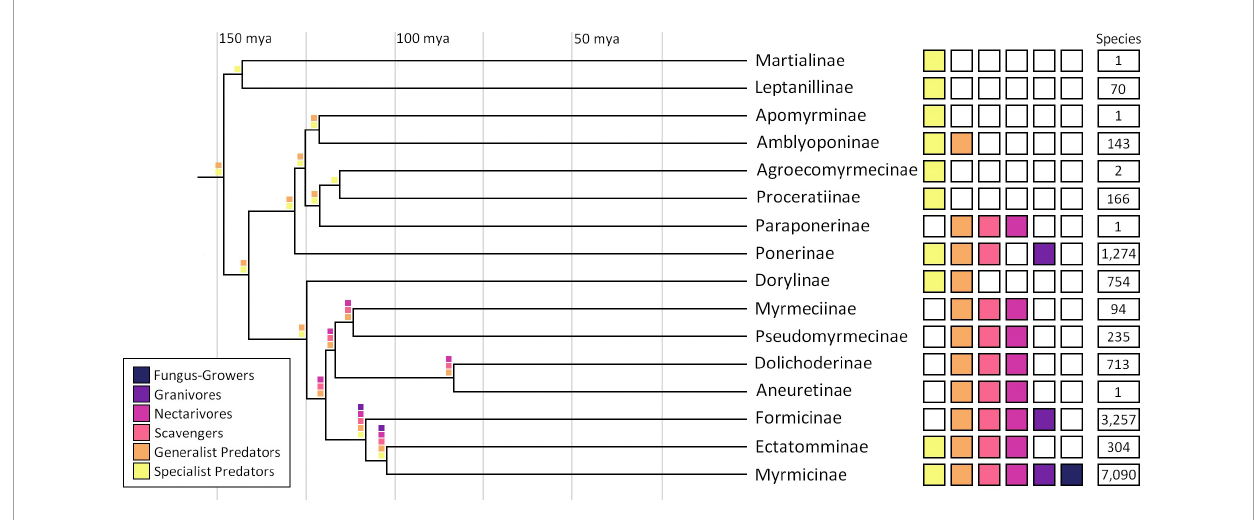
FIGURE1 Ant phylogeny and dietary breadth. Phylogeny based on Romiguier et al. (2022). Diet descriptions from Jayasuriya and Traniello (1985), Lachaud (1990), Cook and Davidson (2006), Heterick (2009), Lenhart et al. (2013), and Ward (2014). Species richness from Bolton (2023).